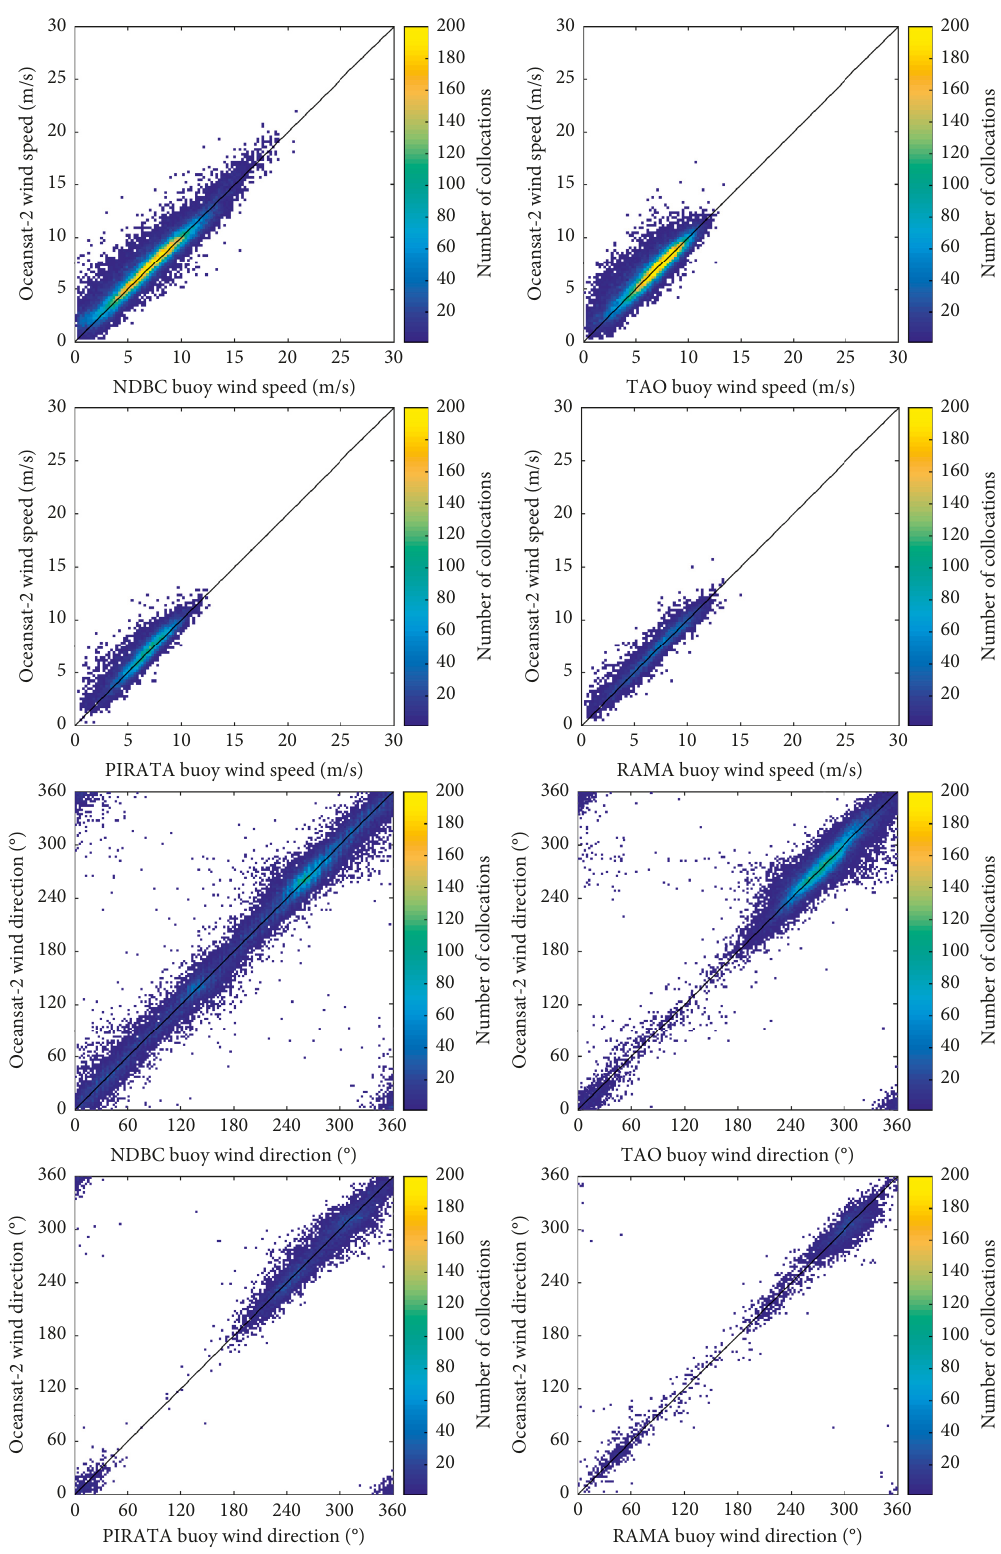
Figure 2: Scatterplots for the comparisons of wind speed and direction between OSCAT and different moored 5 m/s) and large wind speed (more than 13 ∼ 19 m/s for the overall biases of wind speed are close to 0. The positive or different buoys). The RMSEs of wind speed decrease with negative biases show an overestimation or underestimation increasing wind speed when wind speed is lower than 9 m/s of the wind speed by OSCAT at low wind speed (less than